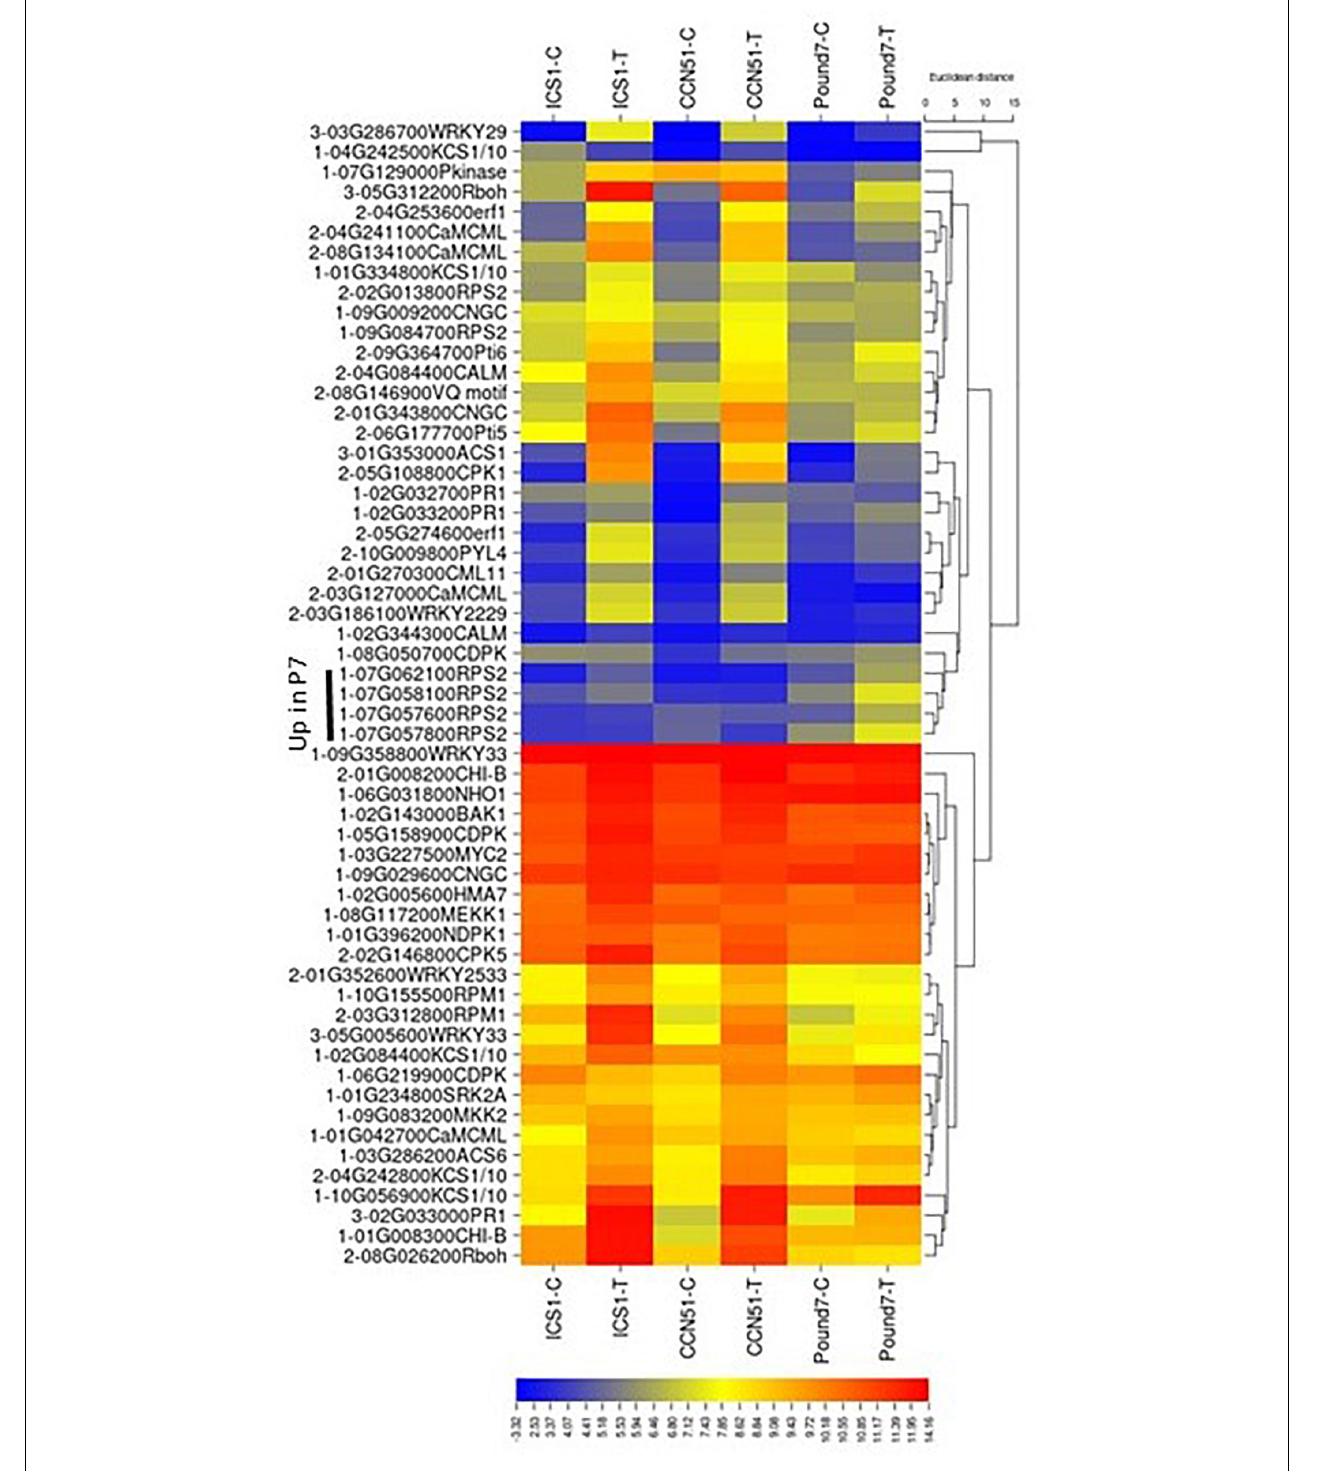
FIGURE 2 | A heat map displaying relative expression levels of induced cacao genes involved in the map-signaling pathway (map04016) and PAMP-mediated and effector-triggered immunity components of the KEGG plant pathogen interactions (map04626) pathway in young red leaves of ICS1, CCN51, and Pound7 24 h after inoculation with 20- µ l drops of zoospores (0.6 × 10 5 zoospores/ml). Initial numbers indicate the number of genotypes with a significantly induced expression between treated and control samples. Numbers represent gene identifications in the cacao transcriptome ( Supplementary Data Sheet 1 ). Terminal letters indicate a gene function/pathway